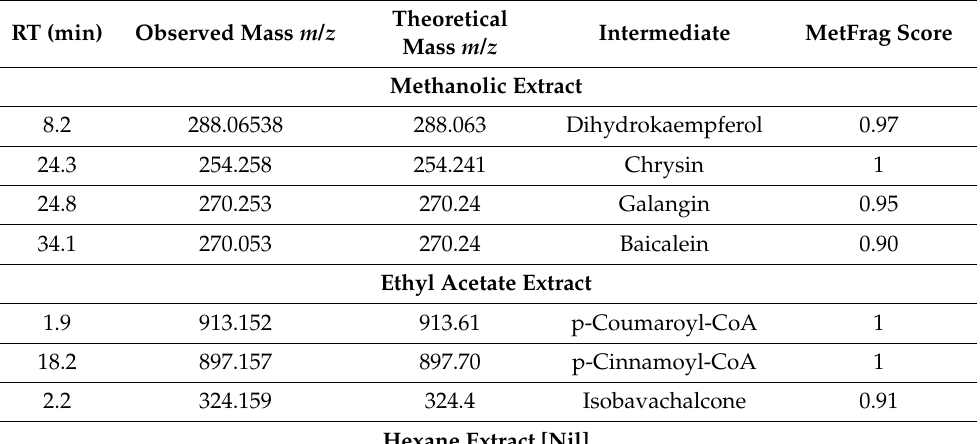
Table 2. Metabolites of the chrysin biosynthesis pathway detected in the methanolic, ethyl acetate, and hexane extract of C. globosum by